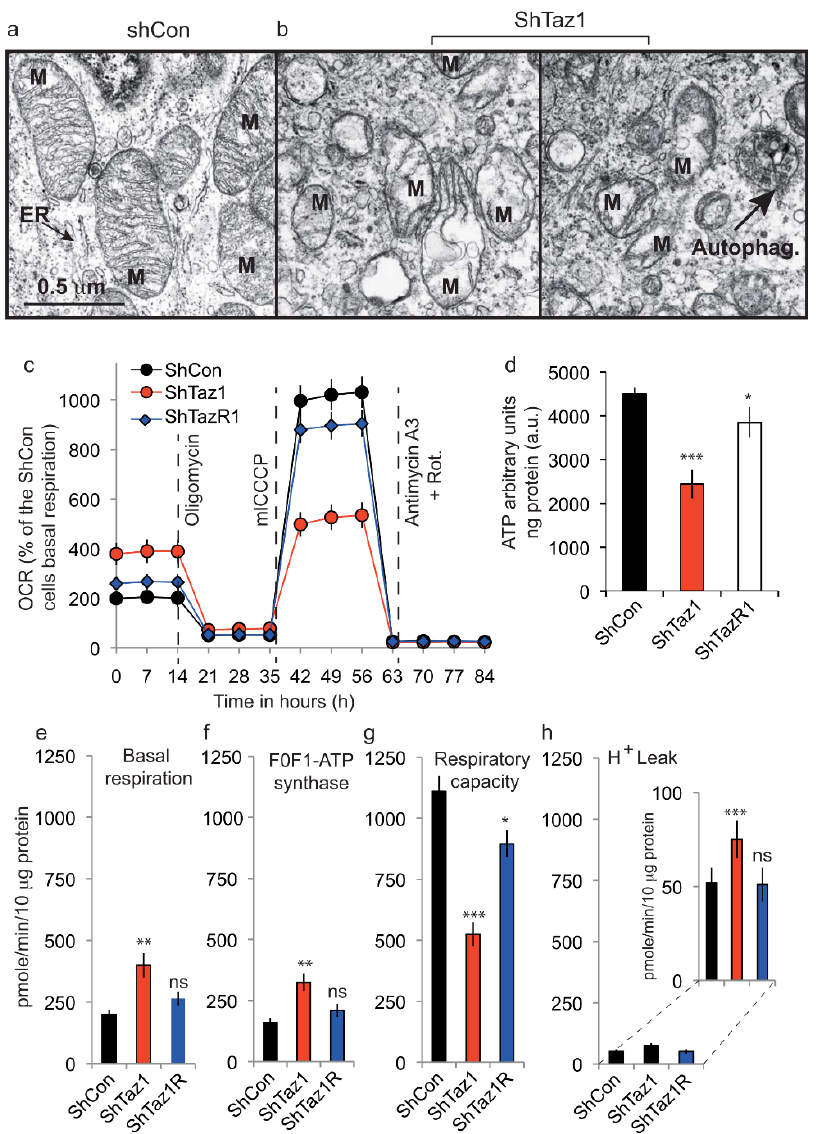
Figure 5. Quantitation of mitochondrial functional parameters; electron microscopy and respiratory activity. ( a , b ) Electron microscopy of the ShWT1 and ShTaz1 cells. Left panel, ShWT1 ( a ) and ShTaz1 ( b , the middle and right panel). In b, two electron microscopy pictures of the different types of mitochondria found for the ShTaz1 cells (middle and left panel). ER; Endoplasmic reticulum, M: Mitochondria; Autoph (indicated by the black arrow), autophagosomes enclosing part of the cytoplasm. ( c ) Analysis of the mitochondrial oxygen consumption rate (OCR) for the three cell lines in response to successive treatments with oligomycin (Oligo, 0.5 µ M, an ATP synthase inhibitor), mClCCP (an uncoupler, 0.5 µ M) and antimycin + rotenone (Rot) (0.5 µ M, complex III inhibitor and for Rot 1 µ M) with a Seahorse device XF24 flux analyzer. ( e ) Deduced by calculations from ( d ) Histogram representation of basal respiration. ( f ) Deduced by calculations from ( d ) Histogram representation of F 0 F 1 ATP synthase activity. ( g ) Deduced by calculations from ( d ) Histogram representation of maximal respiration capacity ( h ) Deduced by calculations from ( d ) Histogram representation of the proton leak (H + leak). Since the H + leak is small, there is an enlarged representation on another scale on the left of the primary histogram. In ( e – h ), the activities are always measured in pmol / min / 10 µ g protein. ns = no significant and * is the p -value ≤ 0.05 and ** is the p -value ≤ 0.01 and *** is the p -value ≤